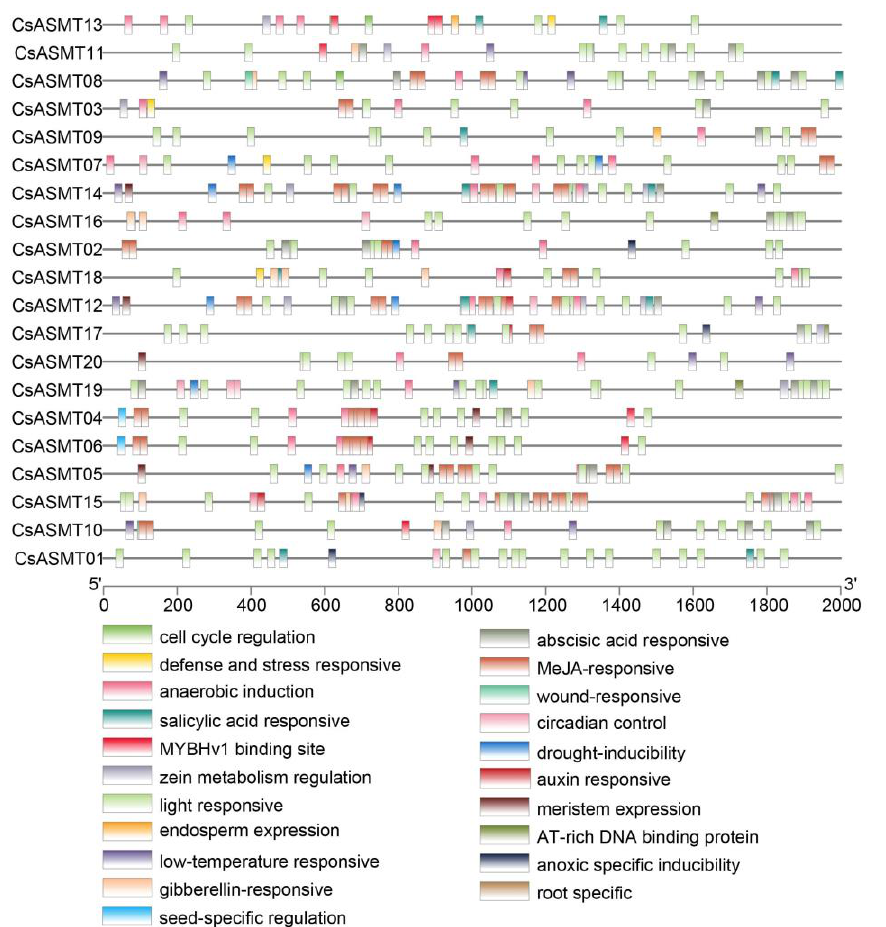
Figure 5. Cis-element analysis of C. sinensis ASMT gene promoters. The binding sites of promoter regions are indicated by the different colored boxes.